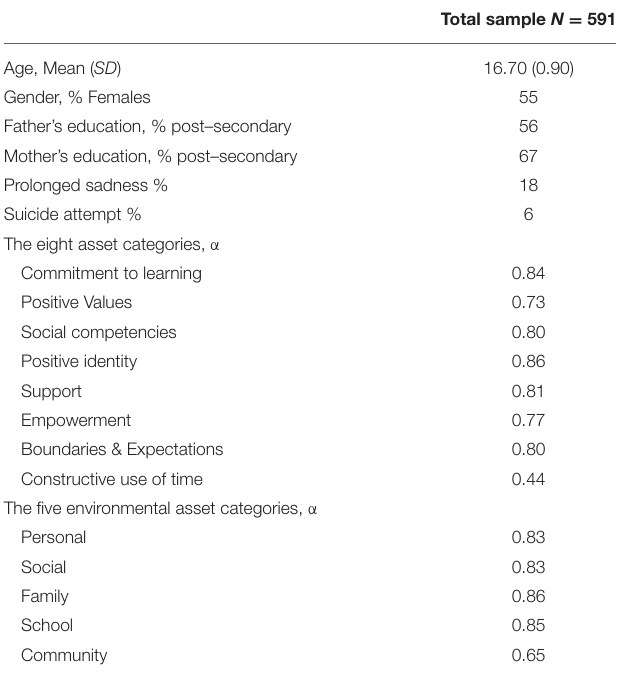
TABLE 1 | Descriptive statistics of study